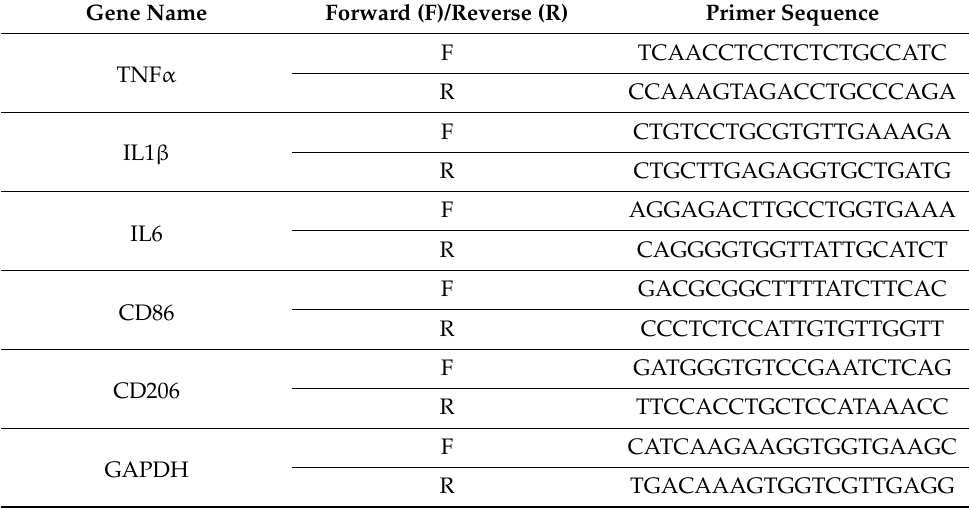
Table 1. List of Primers for